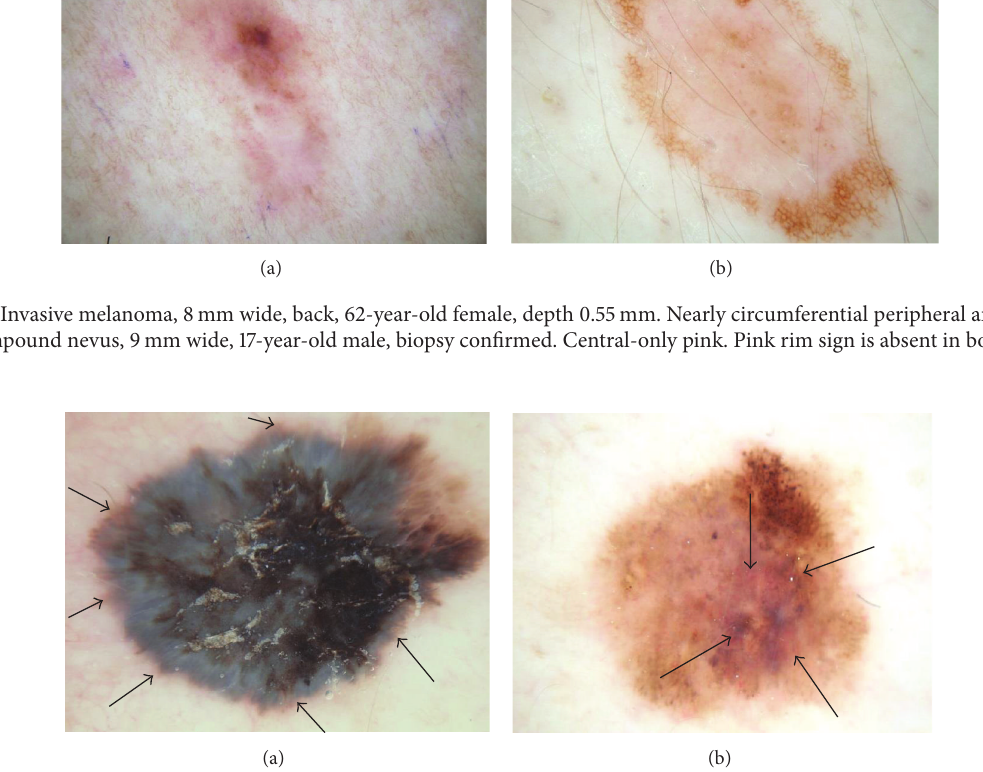
Figure 4: (a) Invasive melanoma, 10mm wide, chest, 50-year-old male, 0.80 mm thick, peripheral-only pink, with circumferential pink rim sign (most prominent at arrows). (b) Clark compound nevus with moderate atypia, 5.5 mm wide, on shoulder, 25-year-old female. Note architectural disorder, irregularly distributed globules, atypical pigment net, and pink and blue color. Pink is most prominent at center (arrows), negative pink rim